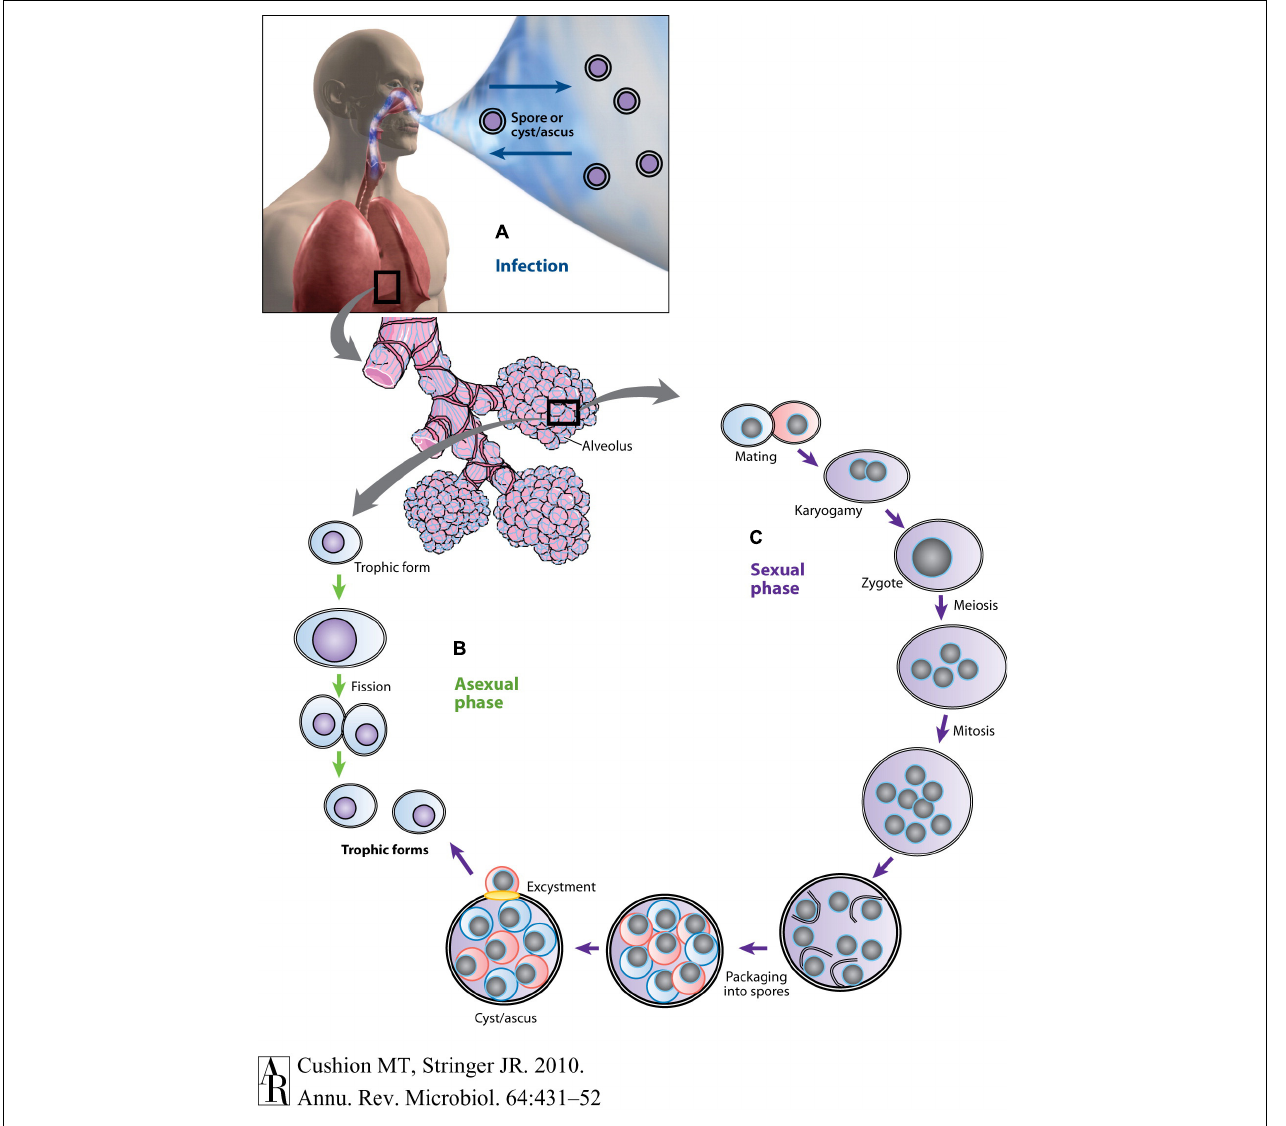
FIGURE 1 | Putative life cycle of Pneumocystis. (A) Infection. Recent studies suggest that the cyst/ascus (containing eight spores) is the agent of infection (inward arrow). After inhalation, the spores ultimately take residence in the terminal portion of the respiratory tree, the alveoli (enlarged bundles of alveoli shown in the illustration). Neither the mechanism of migration to the alveoli nor the form in which the organism arrives in the alveoli (intact ascus or individual spores) is known. It is speculated that the spores are released by exhalation (outward arrow). (B) Asexual phase. Haploid trophic forms are thought to replicate asexually by binary fission, a process whereby a single trophic form duplicates its genetic material and creates two daughter forms of roughly equal sizes. (C) Sexual phase. Two presumptive mating types conjugate, undergo karyogamy, and produce a diploid zygote that progresses through meiosis and then an additional mitosis to produce eight nuclei. The nuclei are packaged into spores by invagination of the ascus cell membranes. After completion, excystment occurs via a protunicate release by unknown mechanisms, which may involve a pore or opening in the cyst wall (yellow oval). The released spores become the vegetative forms, the haploid trophic forms, that can then undergo asexual or sexual replication (Images of man, alveoli purchased from Superstock Photos, http://www.superstock.com). Annual Reviews Authors: There is no need to obtain permission from Annual Reviews for the use of your own work(s). Our copyright transfer agreement provides you with all the necessary permissions. Our copyright transfer agreement provides: “ ... The nonexclusive right to use, reproduce, distribute, perform, update, create derivatives, and make copies of the work (electronically or in print) in connection with the author’s teaching, conference presentations, lectures, and publications, provided proper attribution is given ...